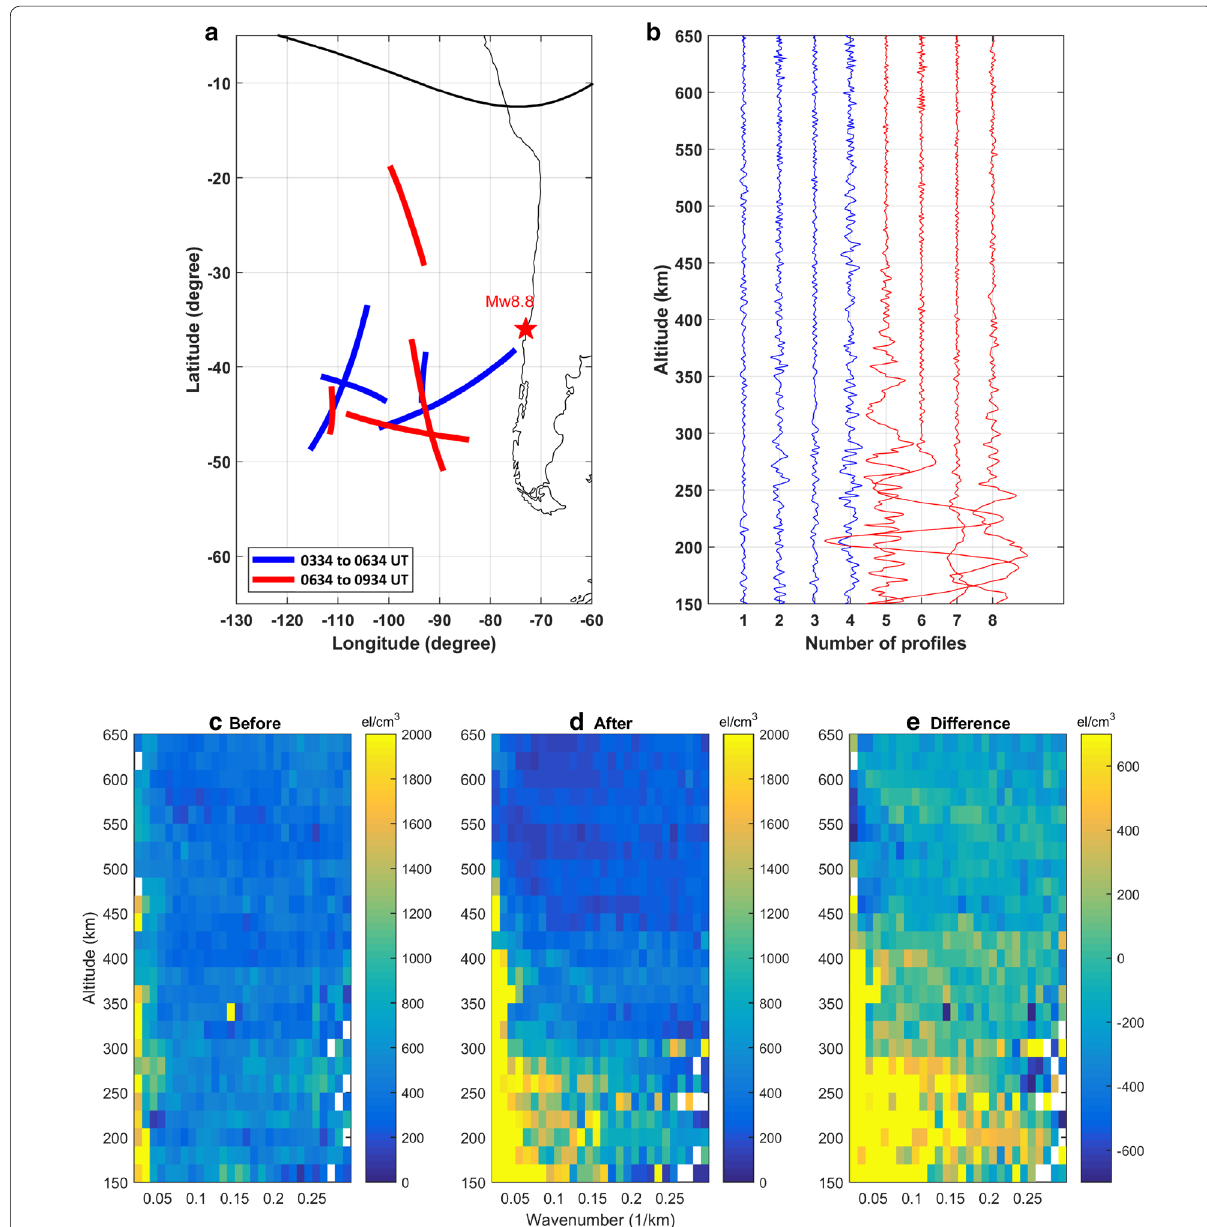
Fig. 4 a Distributions of the tangent points of the F3/C RO electron density (Ne) soundings in the area of eastern South Pacific off Chile during the periods of 3 h before (blue) and after (red) the 27 February 2010 Mw8.8 Offshore Maule, Chile earthquake. b Fluctuations of the Ne profiles before (blue) and after (red) the earthquake. The trend determined by the empirical model decomposition has been removed from the raw profiles for showing the fluctuations. The Hilbert spectra of the fluctuations c 3 h before and d 3 h after the earthquake. e The difference between the two spectra ( d – c